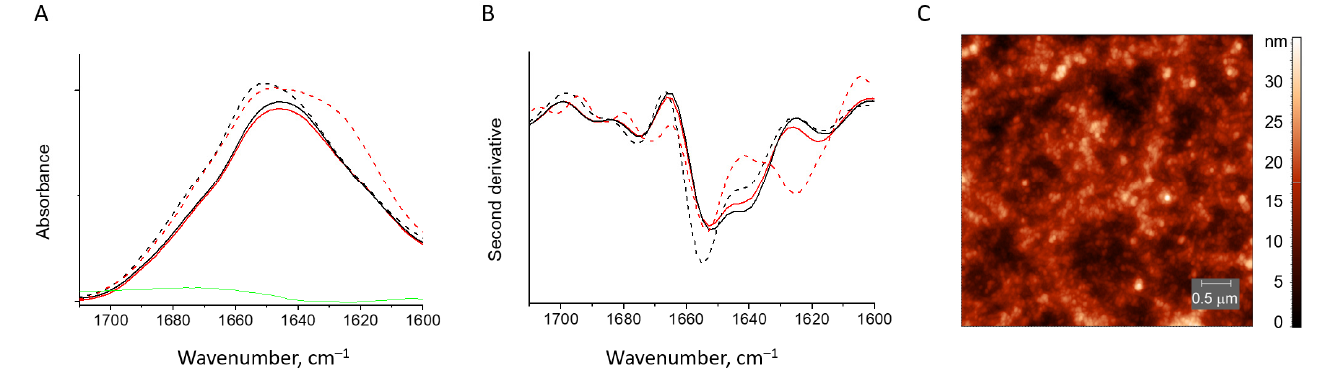
Figure 7. Absorbance spectra ( A ) and second derivative spectra ( B ) of HEWL fibrils (dashed red line) and those mixed with κ -carrageenan (solid red line), native HEWL mixed with κ -carrageenan (solid black line), native HEWL (dashed black line). AFM image of the trace from the gel formed by HEWL fibril and κ -carrageenan mixture ( C ).